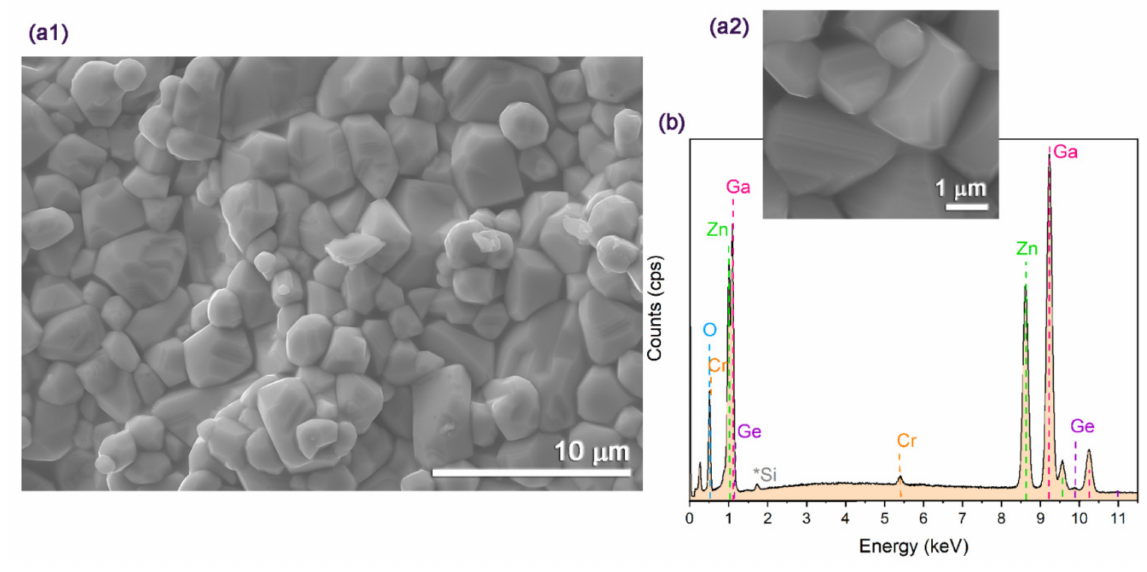
Figure 3. ( a1 , a2 ) SEM images of ZGGO:Cr pellets, ( a2 ) shows in a higher magnification image revealing the polyhedral nature of the grains. ( b ) EDS spectrum of ZGGO:Cr pellets showing the identification of the elements Zn, Ga, Ge, Cr, and O; the * correspond to Si contamination.